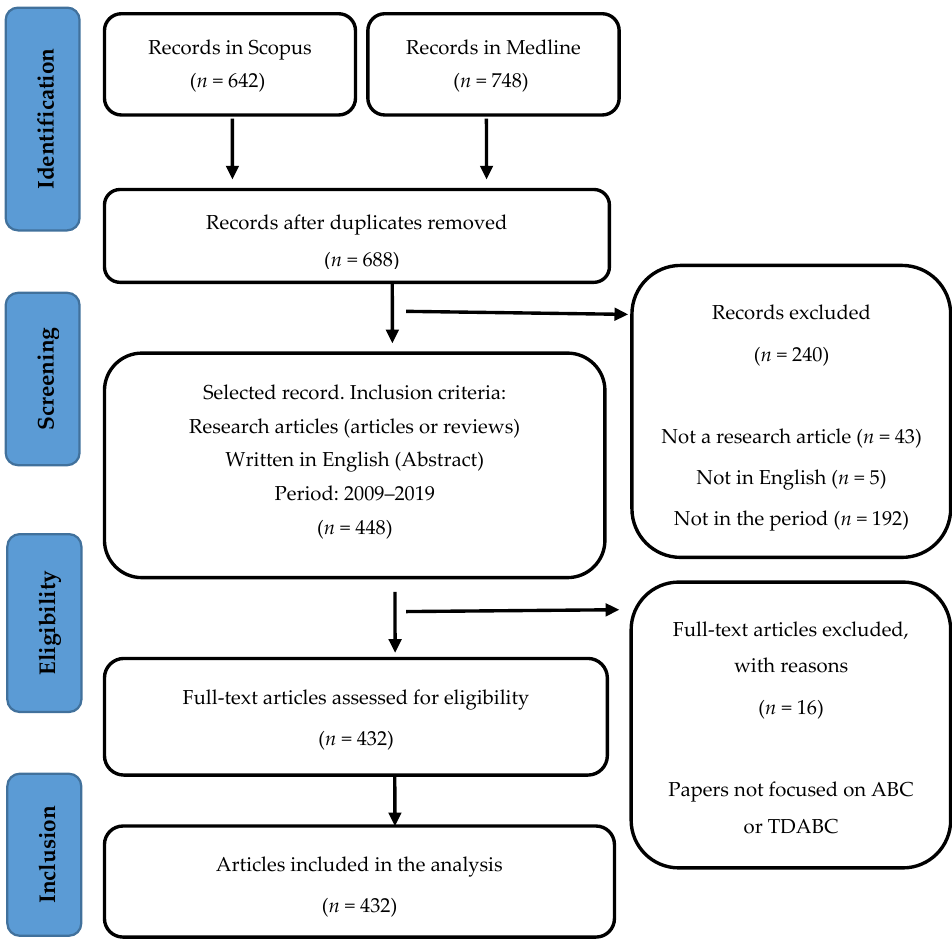
Figure 1. PRISMA flow adapted from Moher 2009 (search conducted on 18th September 2020).